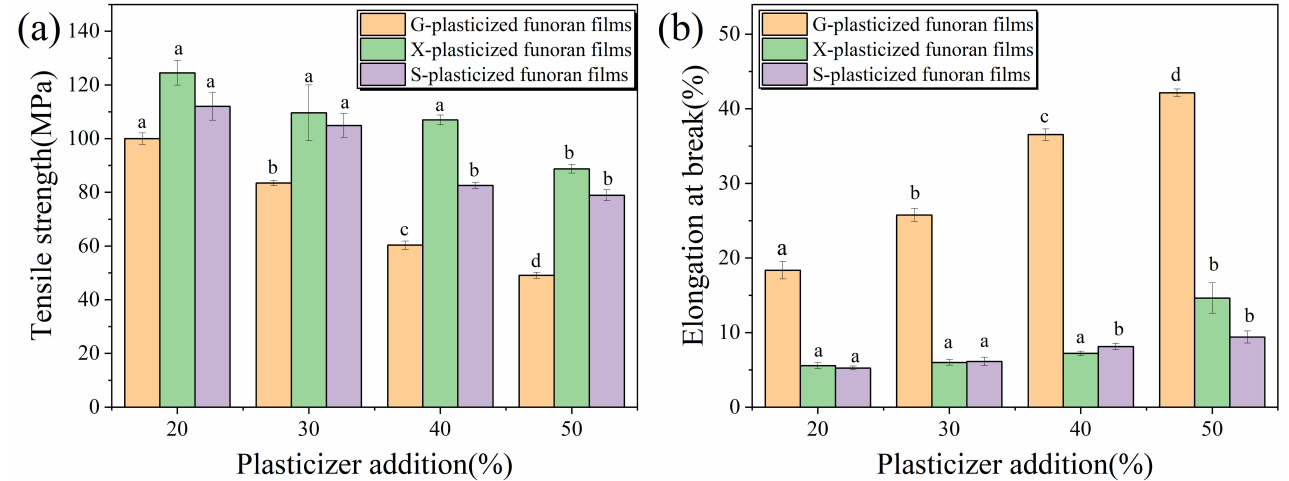
Figure 6. Effects of G, X and S addition on the TS ( a ) and EB ( b ) of the funoran films. The different superscript letter (a–d) indicates significant